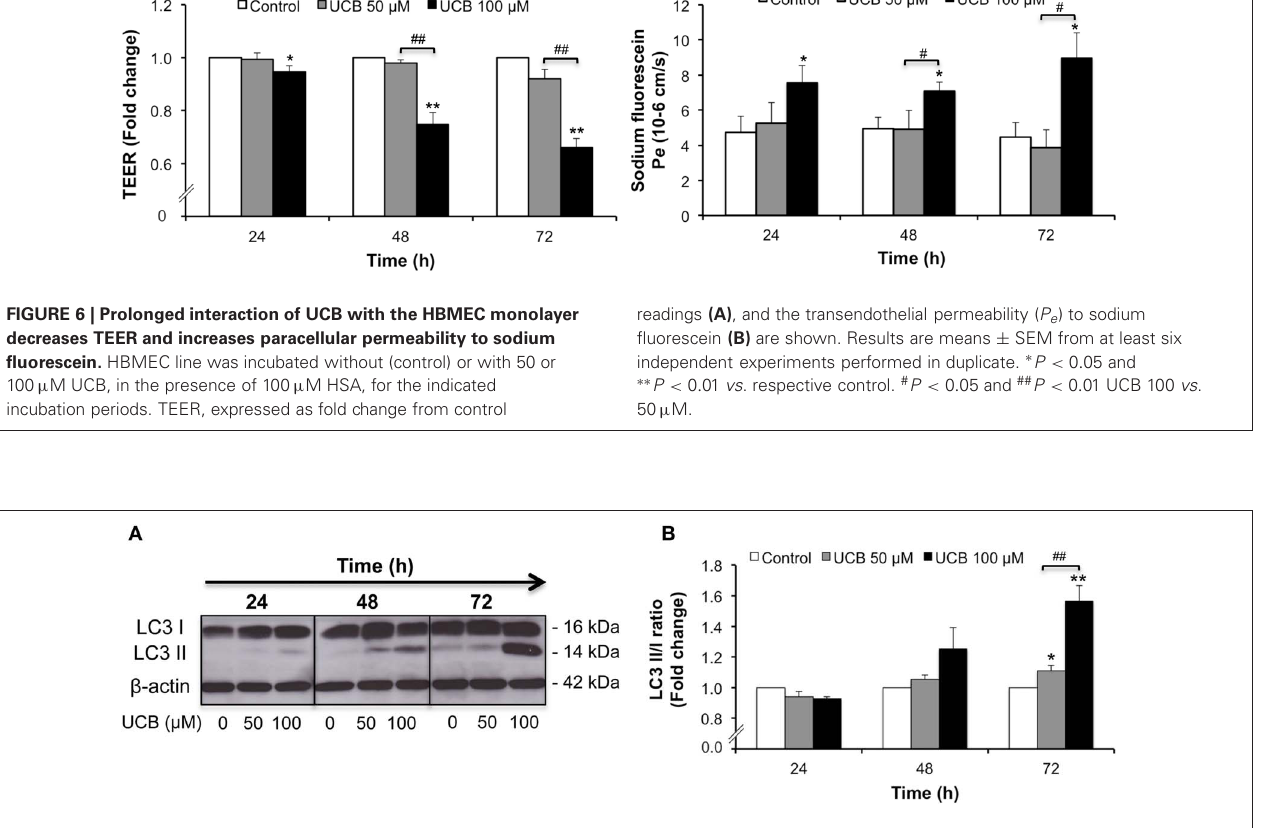
LC3 I and II band intensity was done by scanning densitometry and the ratio between the membrane-bound and the cytosolic forms was calculated and standardized with respect to β -actin protein (B) . Results are means ± SEM from at least four independent experiments performed in duplicate. ∗ P < 0 . 05 and ∗∗ P < 0 . 01 vs . control. ## P < 0 . 01 UCB 100 vs . 50 μ M.